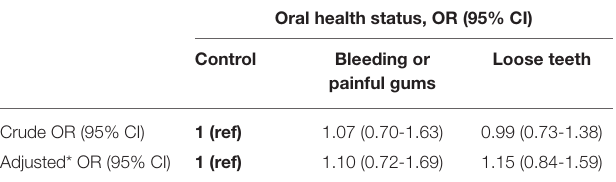
TABLE 2 | Association between oral health indicators and risk of COVID-19